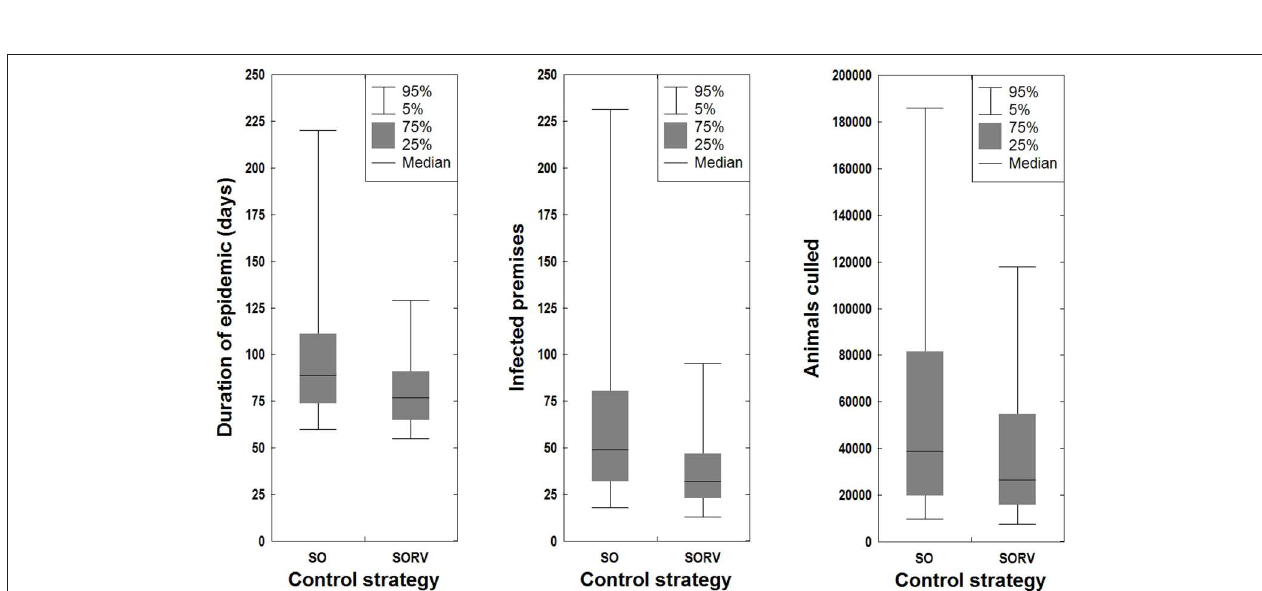
FIGURE 10 | Effect of control strategy on outbreak duration, outbreak size, and number of culled